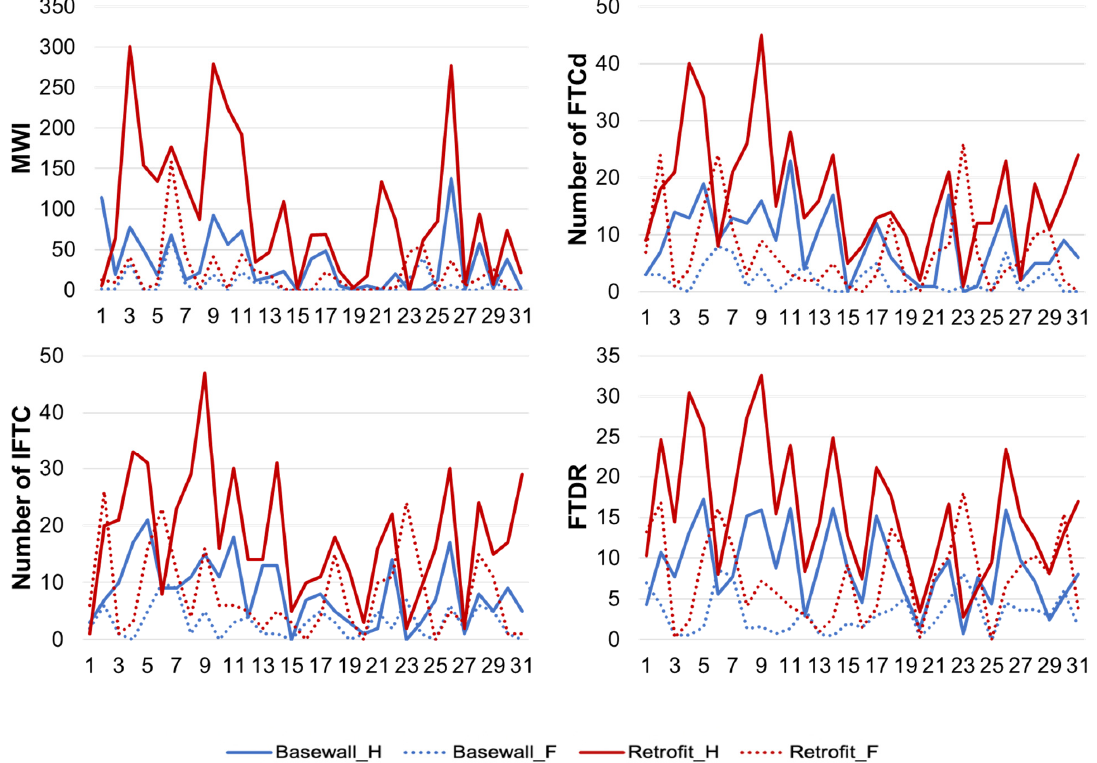
Figure 8. Freeze-thaw performance indicators calculated for a base wall and a retrofitted wall (100 mm spray foam and S crit of 0.25) facing the prevailing WDR orientation in Vancouver under historical (1986–2016) and future climates (2062–2092).